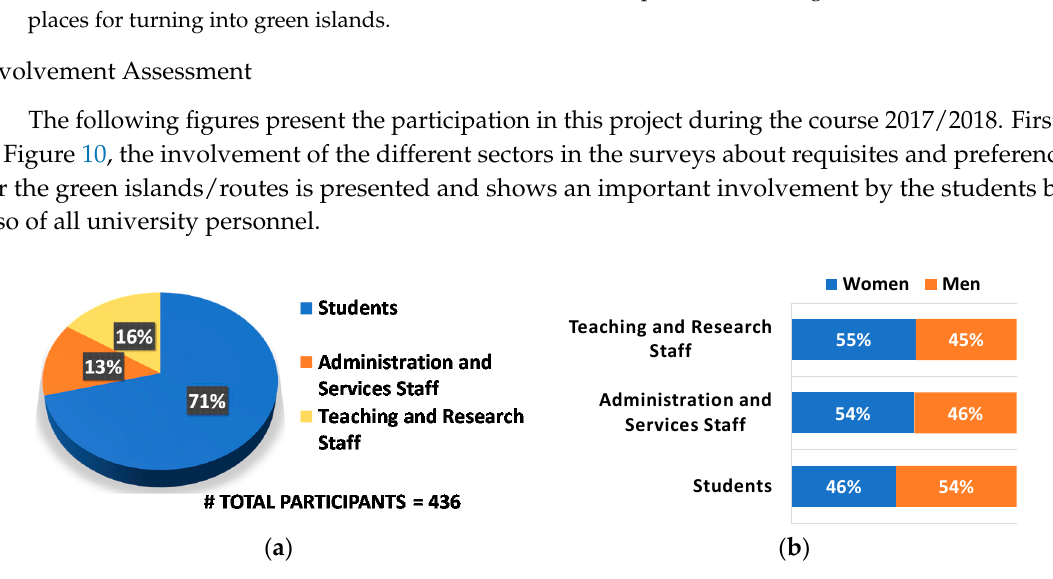
Figure 10. Participation in the surveys on users’ requirements per university community sector ( a ), per gender ( b ).